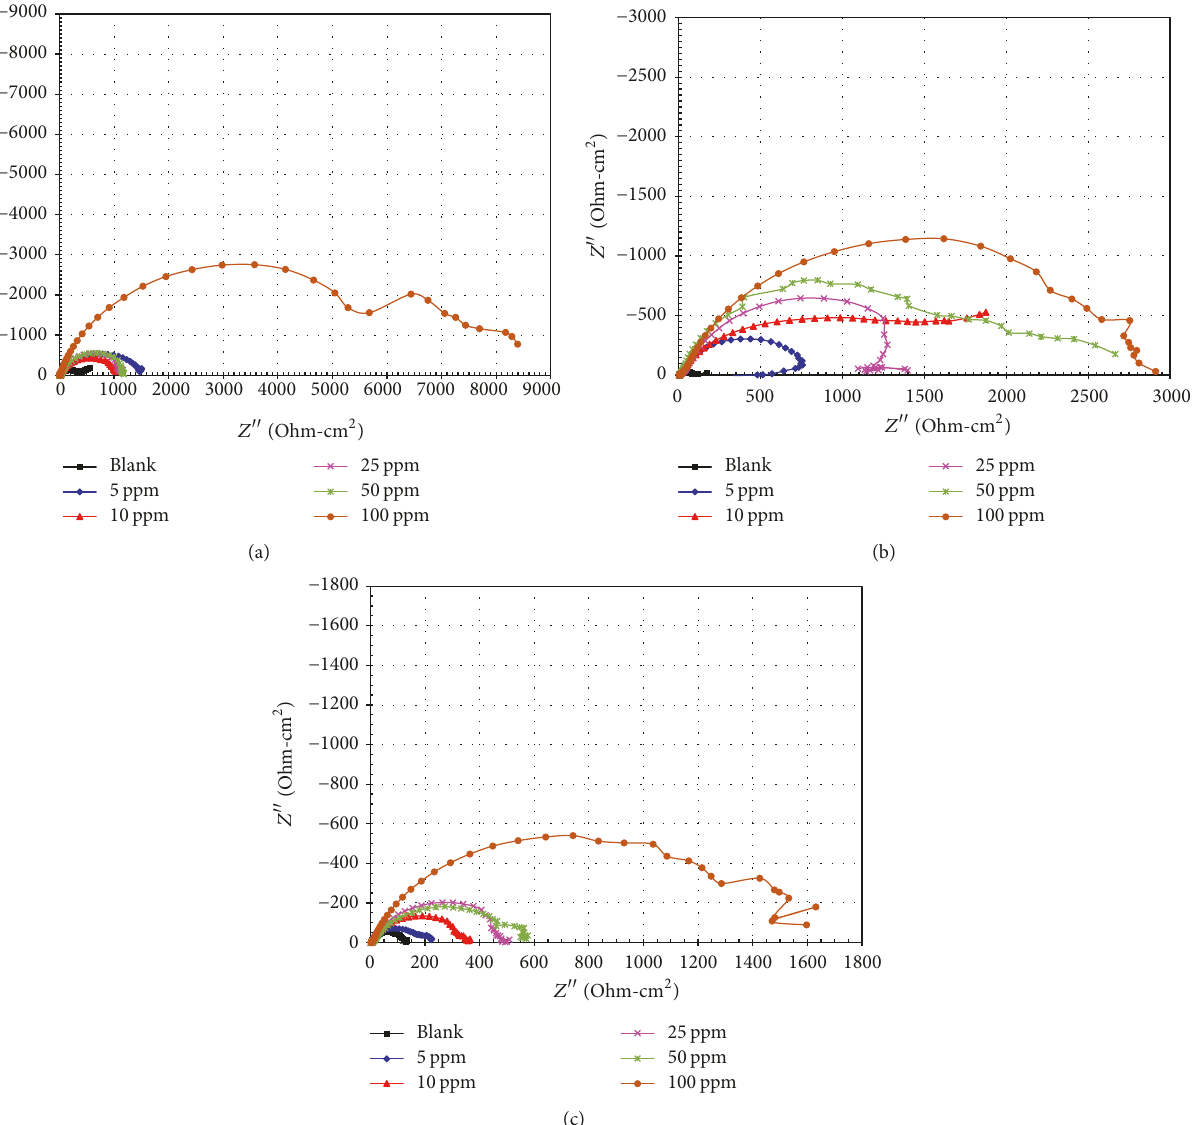
Figure 10: EIS spectra for API X-70 steel in CO 2 -saturated saline solution at different concentrations of inhibitor: (a) 30 ∘ C, (b) 50 ∘ C, and (c) 70 ∘ C, after 24 hours of